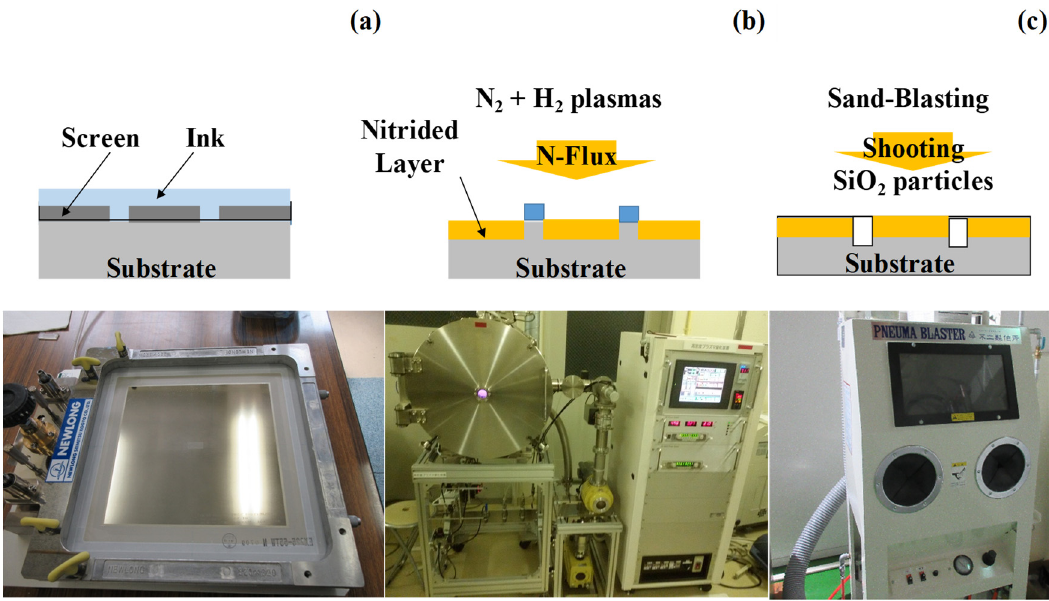
Figure 2. A schematic view and photo of plasma 3D-printing facilities used in the present experimental setup. ( a ) Screen-printing for micropatterning onto the substrate, ( b ) plasma nitriding for selective nitrogen supersaturation relative to unprinted surface areas, and ( c ) sand-blasting for selective removal of un-nitrided parts.